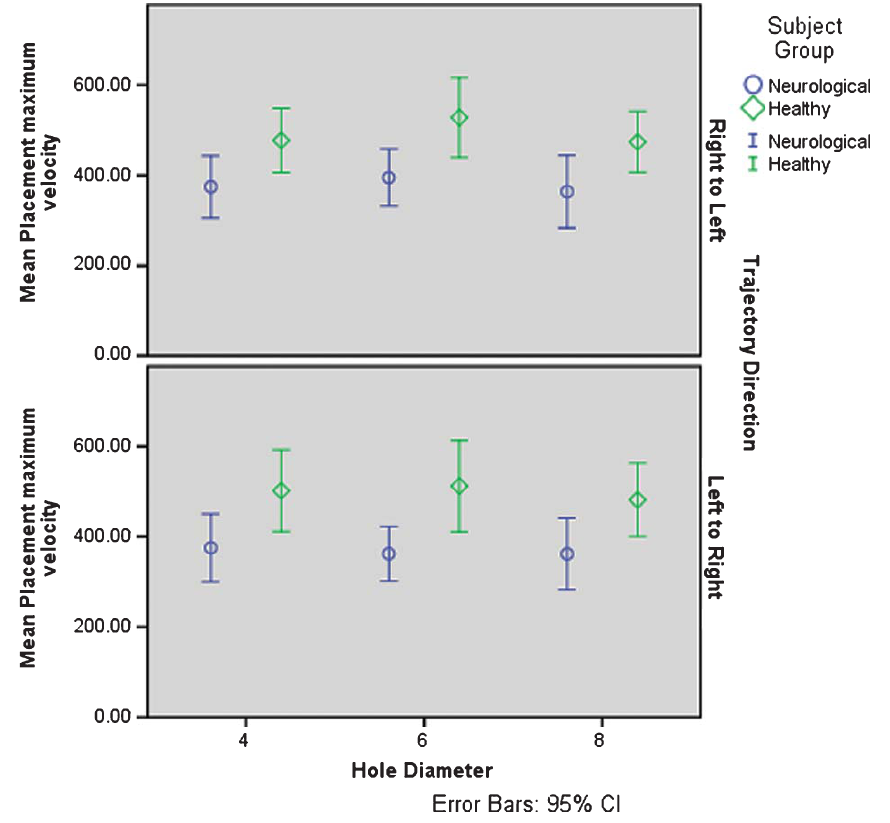
Fig. 8. Comparing maximum velocity for R2L and L2R half cycles and subject